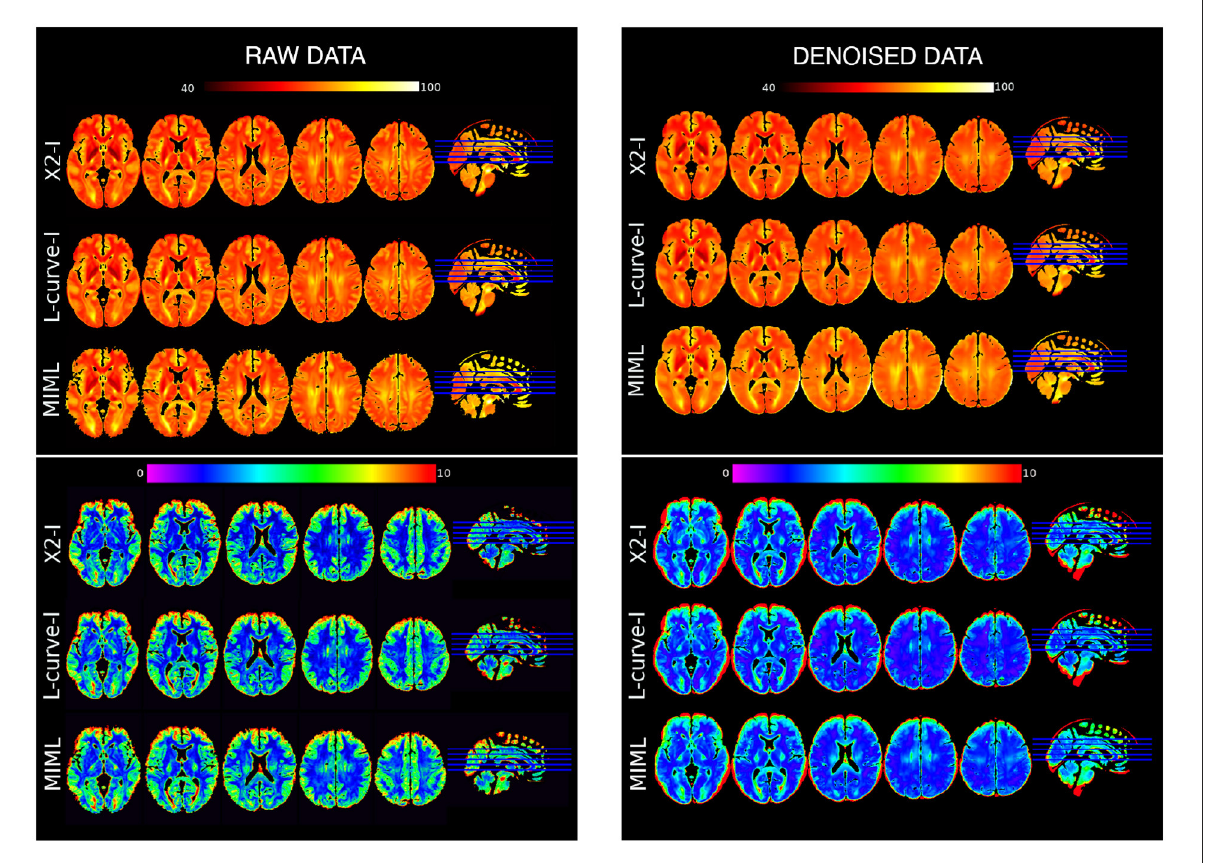
FIGURE3 Whole-brain voxelwise T 2 IE mean (upper panels, hot colormap) and standard deviation (lower panels, cold colormap) maps for the three reconstruction methods: X 2 − I , L-curve − I , and MIML. Left column, raw data. Right column, denoised data.